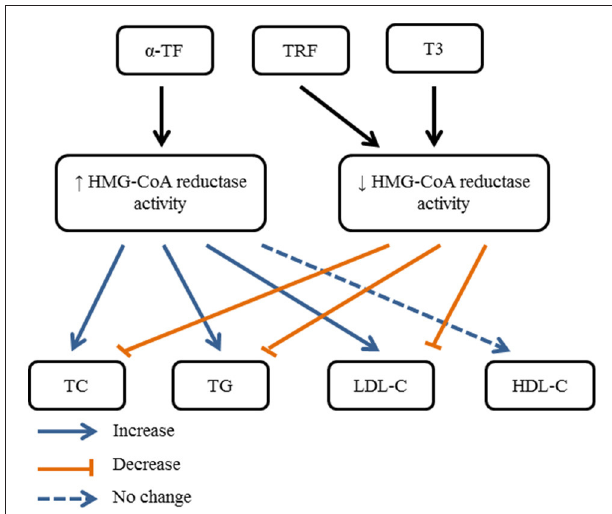
FIGURE 1 | Summary of possible hypocholesterolemic and hypercholesterolemic actions of tocopherol and tocotrienol, mediated through activation or inhibition of HMG-CoA reductase